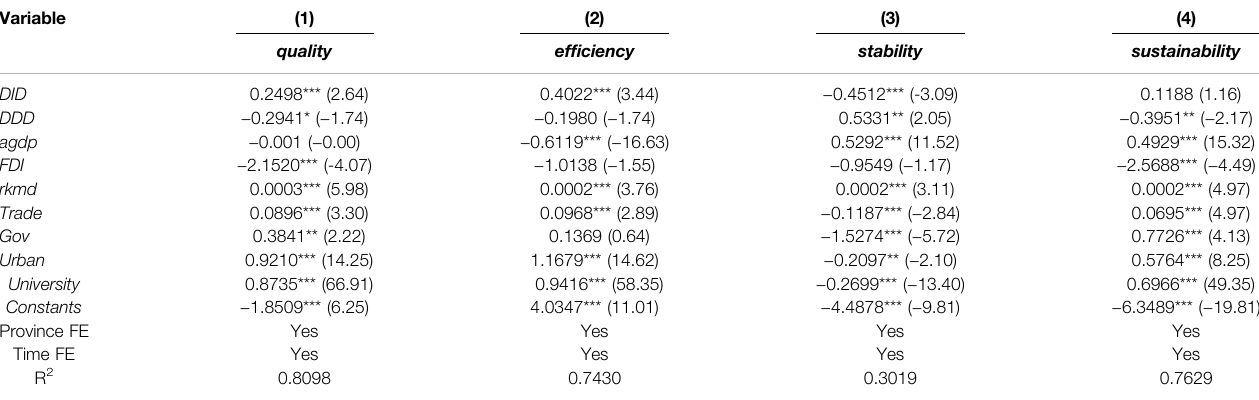
TABLE 6 | Results of the geographical location heterogeneity analysis.